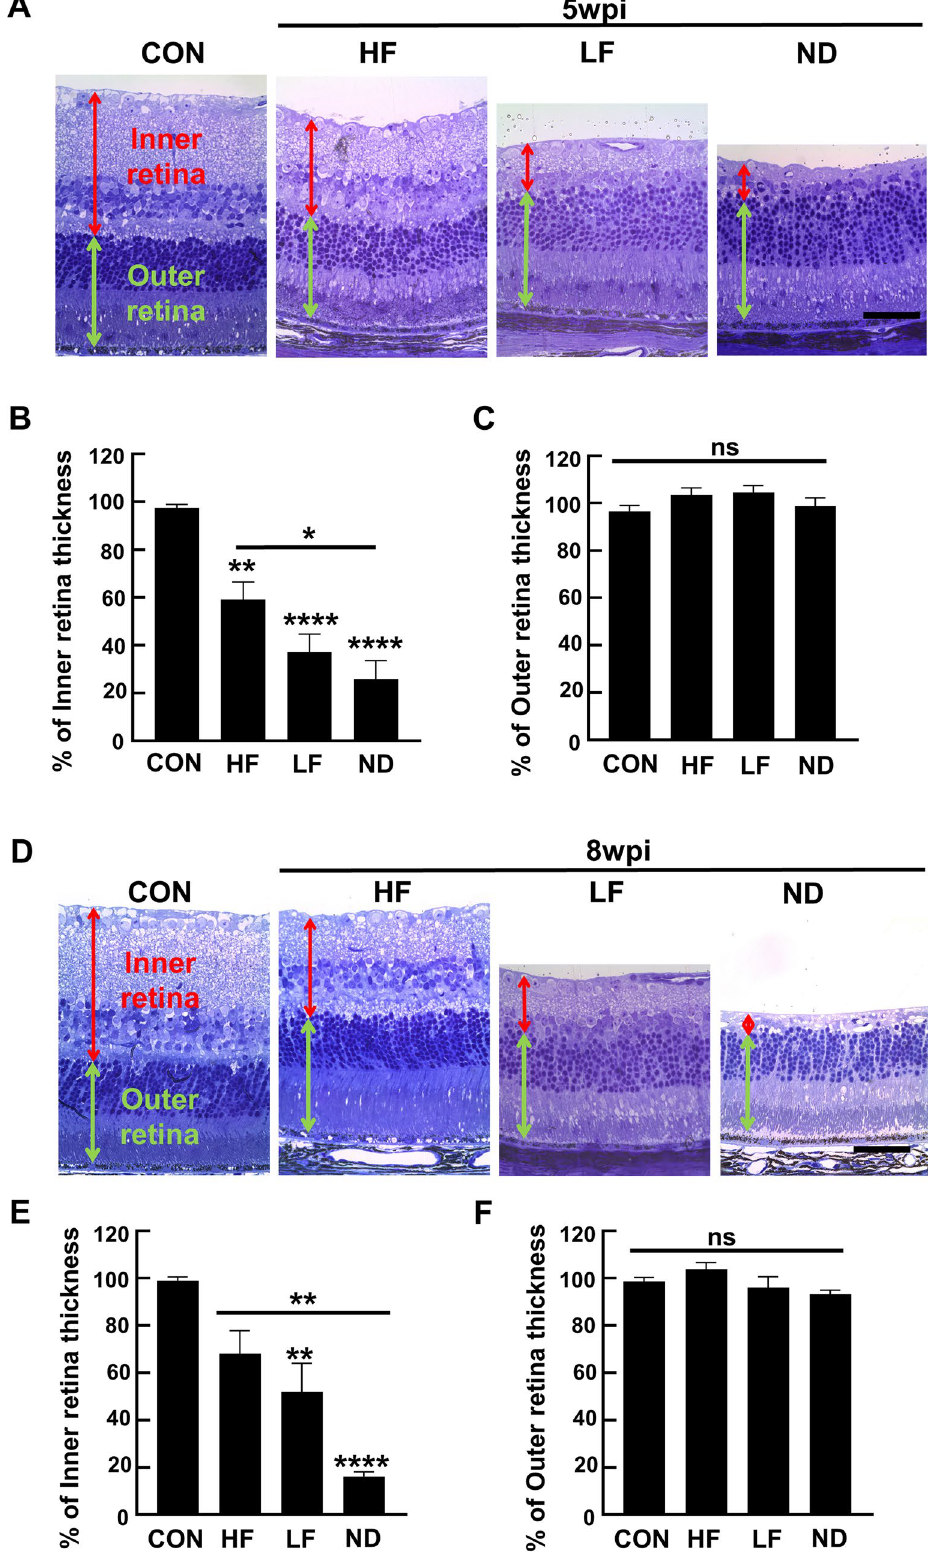
Figure 4. Degeneration of the inner retina: severe in ND, but much milder in HF and LF groups. ( A,D ) Representative light microscope images of semi-thin transverse sections of retina stained with toluidine blue in the corresponding groups at 5 and 8wpi. Scale bar, 50 µm. ( B,E ) Quantification of inner retina thickness at 5 and 8wpi, represented as percentage of SO eyes compared to CL eyes. ( C,F ) Quantification of outer retina thickness at 5 and 8wpi, represented as percentage of SO eyes compared to CL eyes. Data are presented as means ± s.e.m. 5wpi: Control (CON): n = 8; HF: n = 10; LF: n = 10; ND: n = 10; 8wpi: Control (CON): n = 8; HF: n = 10; LF: n = 10; ND: n = 6, * p < 0.05, ** p < 0.01; one-way ANOVA with Tukey’s multiple comparison